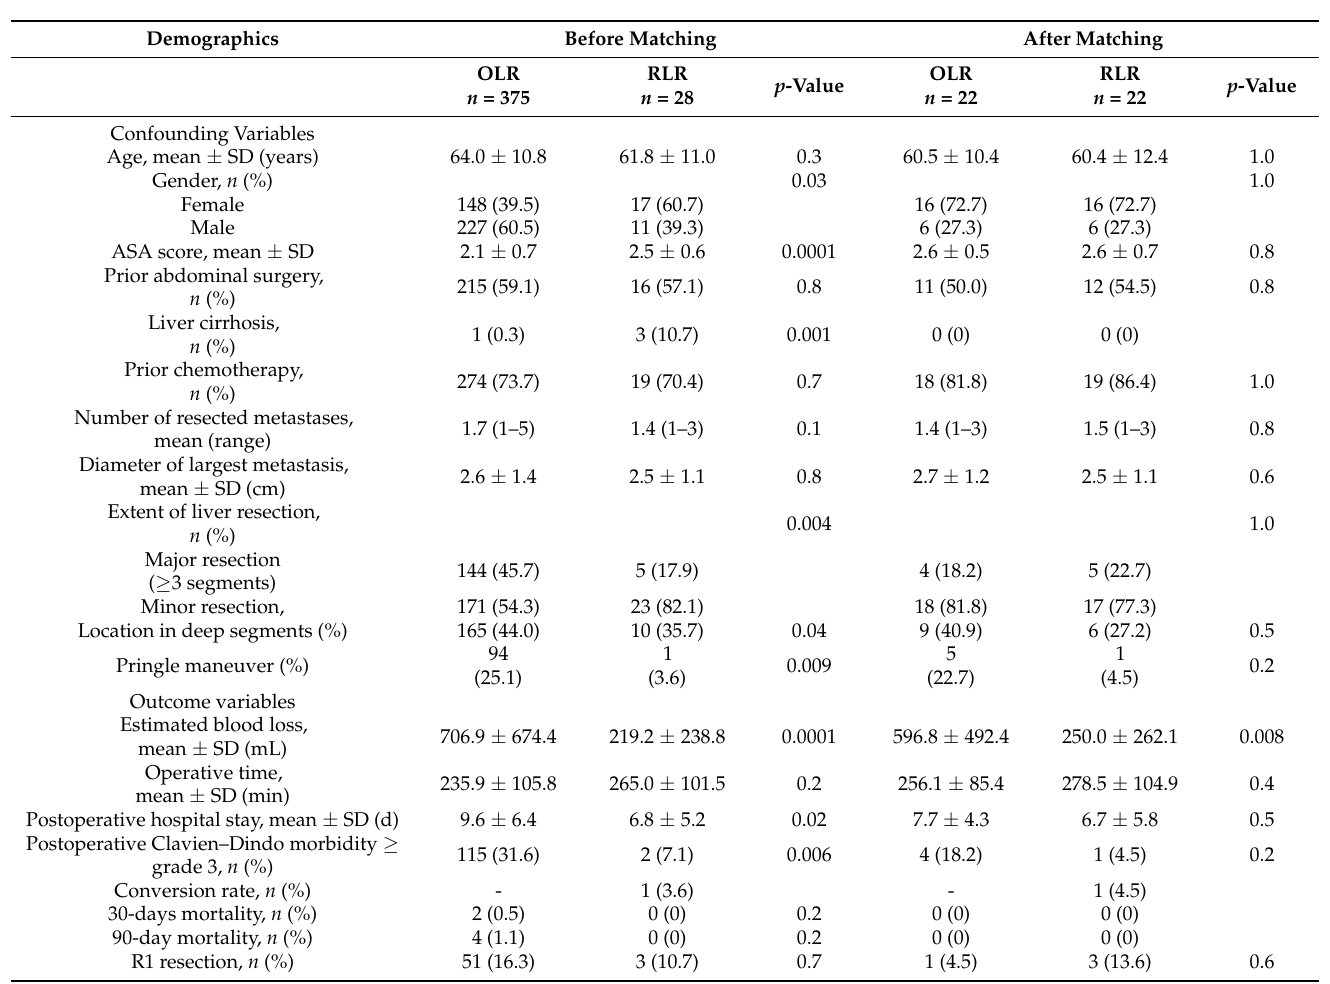
Table 3. Demographics/confounding variables and clinical outcome variables of patients receiving open (OLR) or robotic liver resection (RLR) for colorectal liver metastasis before and after propensity score